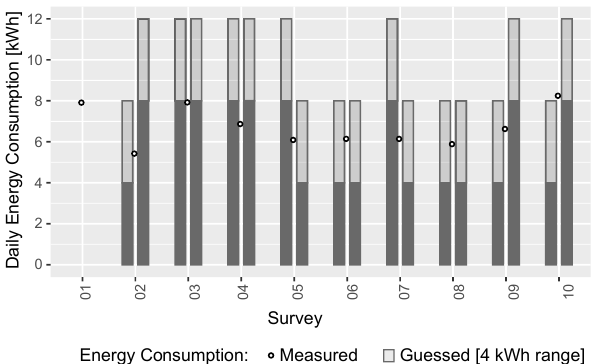
Figure 7. Self-assessment of the residents about their mean daily energy consumption vs. actual measurements taken.